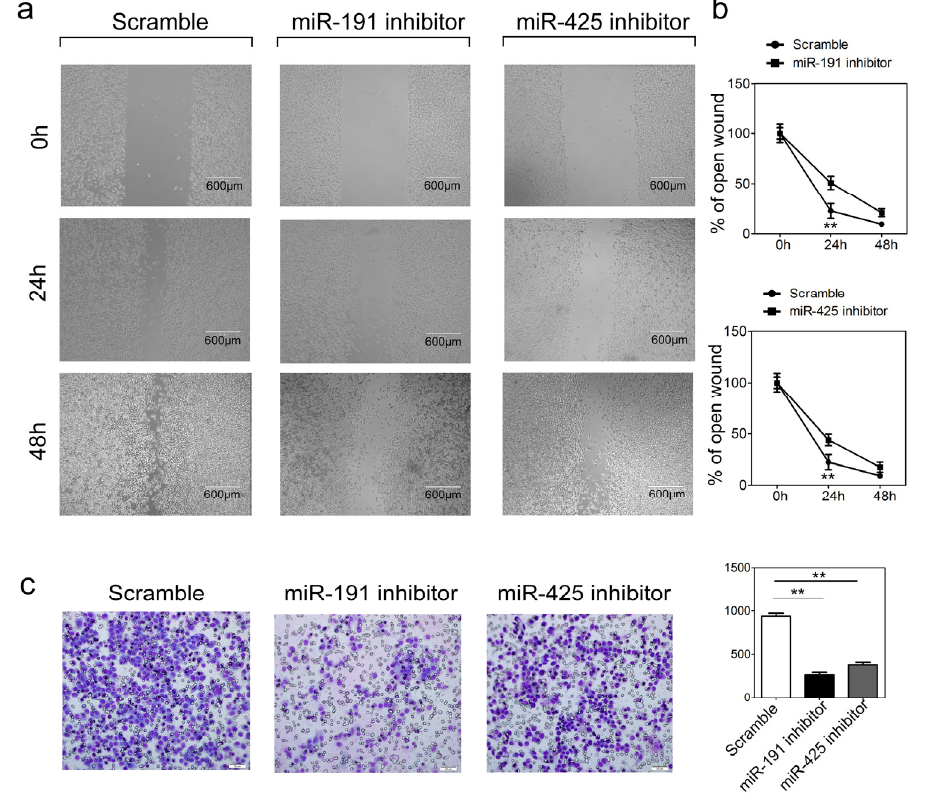
Figure 5. The influence of miR-191 and miR-425 expression on GC cell migration and invasion. ( a , b ) Wound healing assays of HGC-27 cells after treatment with miRNA inhibitor or scramble control. Relative ratios of wound closures per field is shown in ( b ); ( c ) Transwell analysis of HGC-27 cells after treatment with miRNA inhibitor or scramble control. The relative ratios of invasive cells per field are shown. Scale bar: 50 µm. Error bars represent the standard deviation obtained from three independent experiments. ** p <